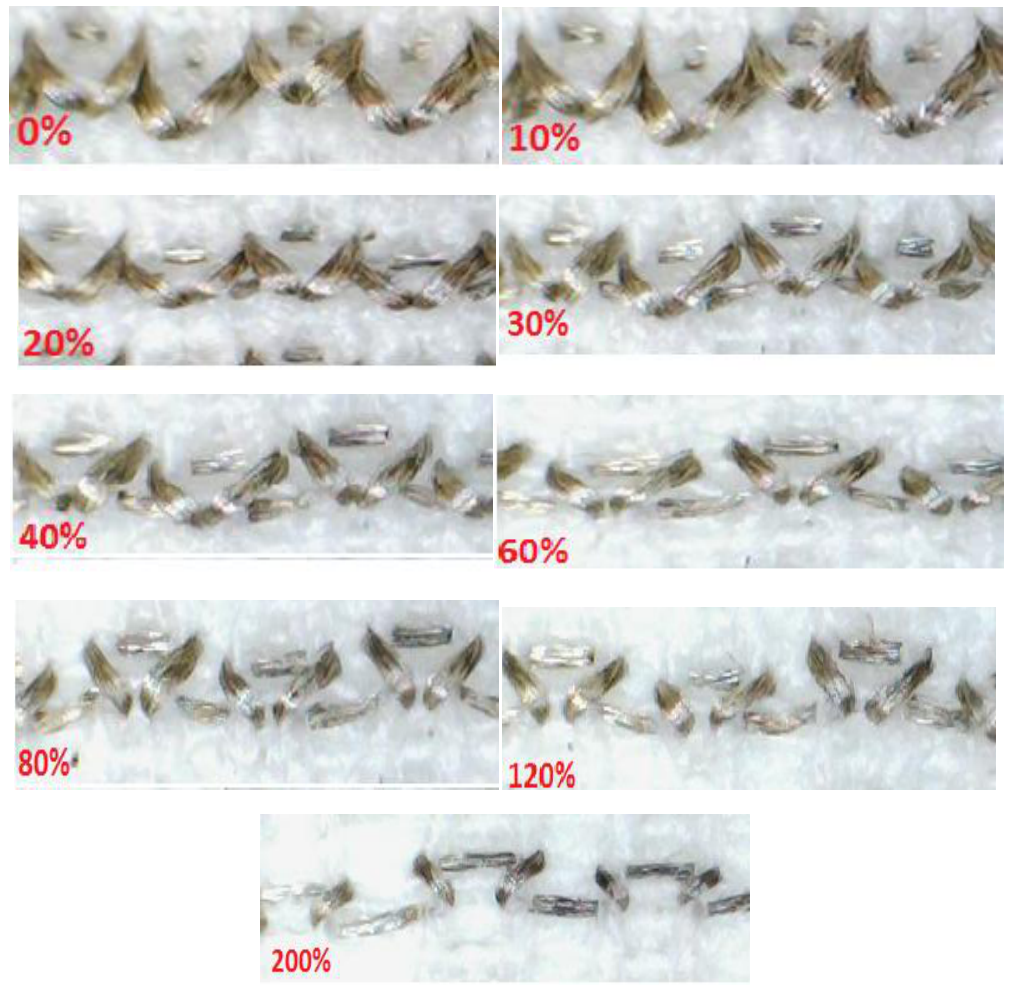
Figure 7. Magnified images of one conductive course during various levels of textile extension from 0% to